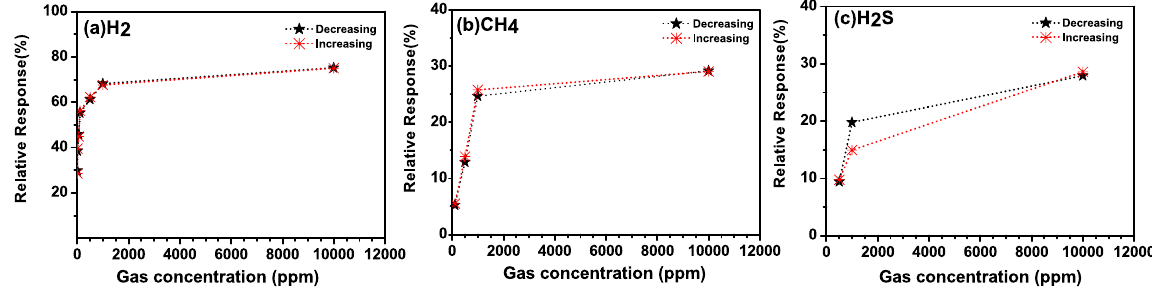
Figure 4. ( a–c ) Hysteresis studies for H 2 , CH 4 and H 2 S at 150 °C for increasing and decreasing gases concentration.